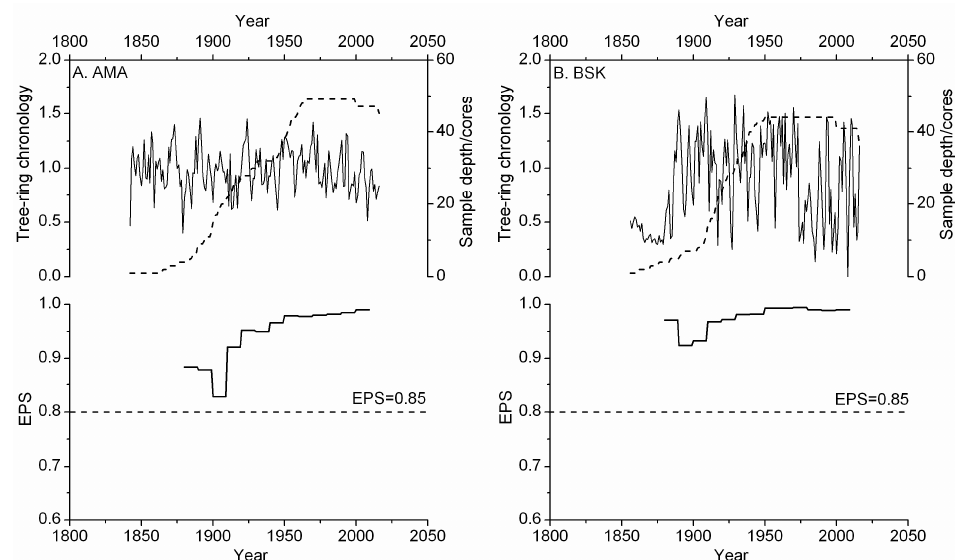
Figure 4. Tree-ring chronologies (thin lines) with their sample depth (dashed lines). Thick lines represent EPS data: ( A ) AMA and ( B ) BSK.